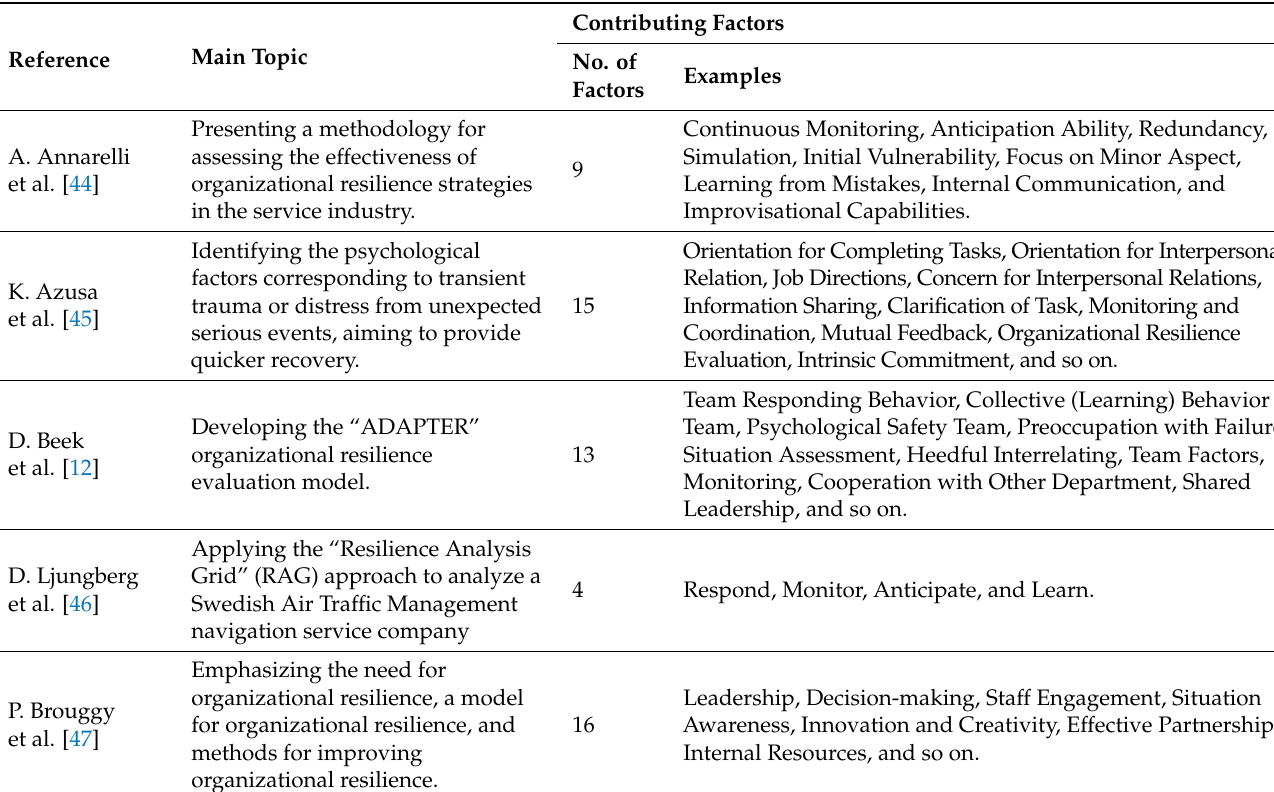
Table 3. Summary of identified contributing factors from the business